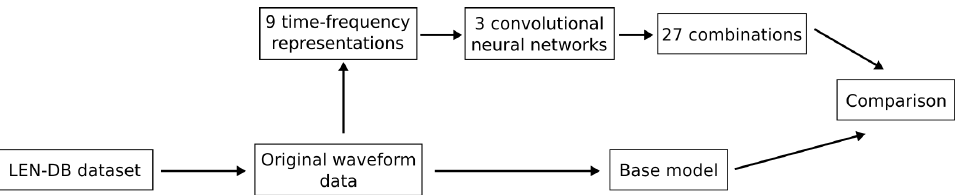
Figure 1. A diagram depicting the main phases of the